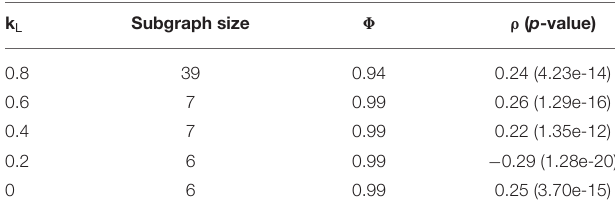
TABLE 5 | Correlation with different modularity and correlation weights.